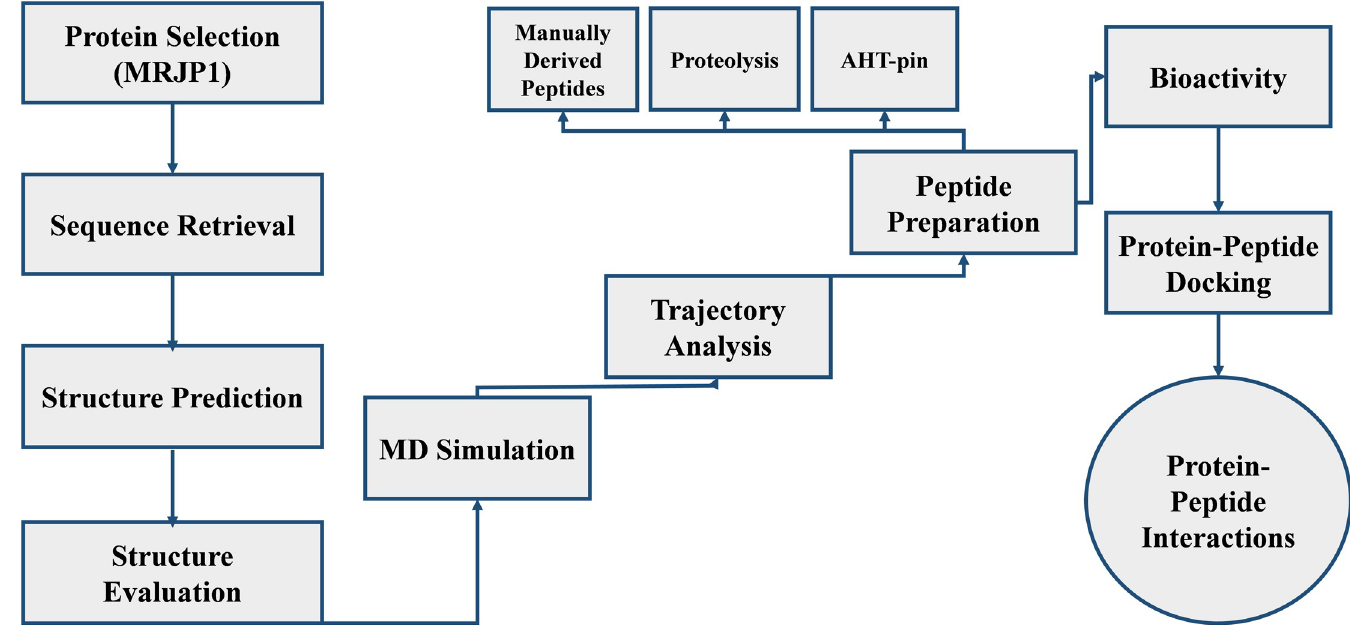
Fig 6. The methodology of current research